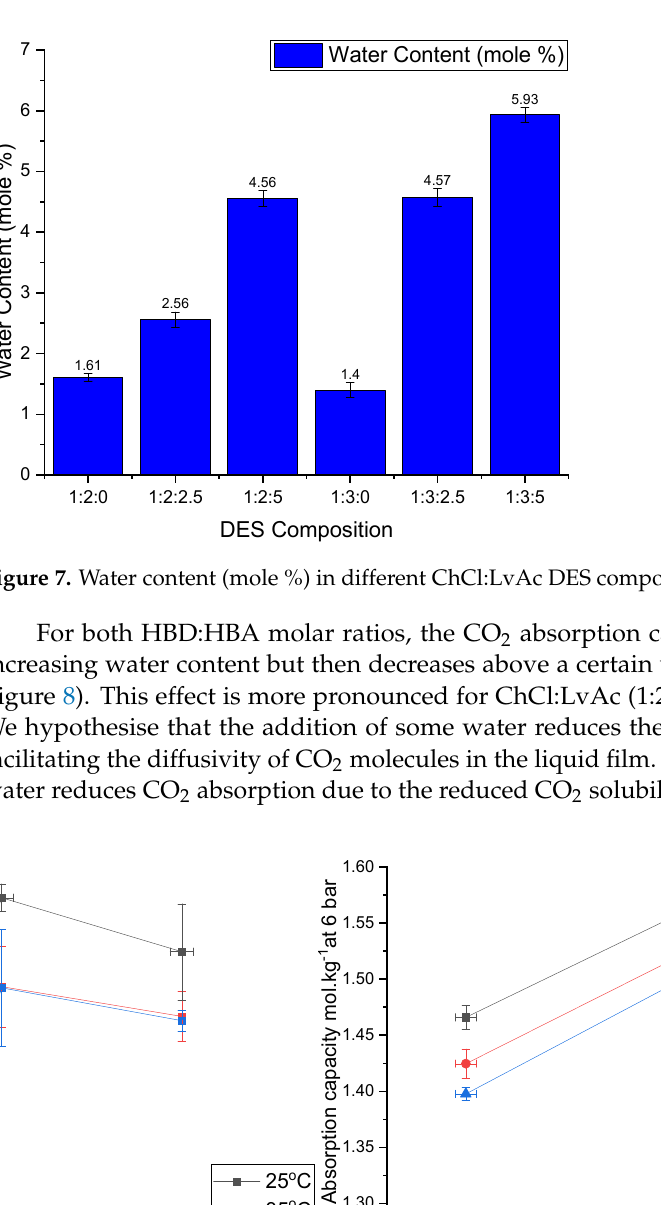
Figure 8. The effect of water content on the CO 2 absorption capacity of ChCl:LvAc (1:2) ( left ) and (1:3) ( right ) at 6 bar and at different temperatures.